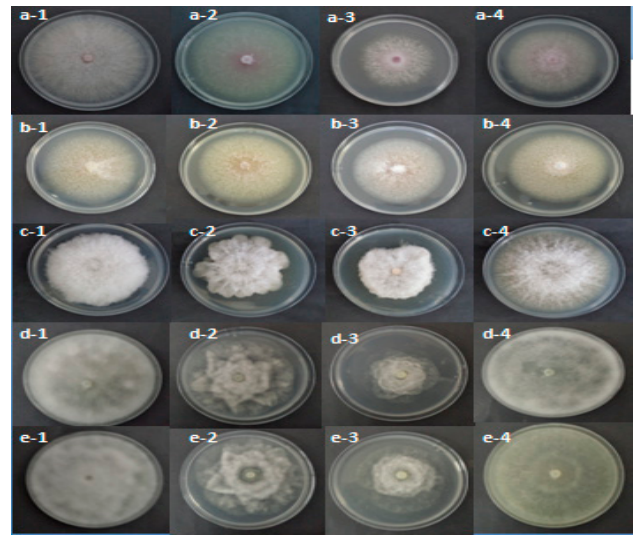
Figure 1. Effect of methanolic (2), dichloromethane (3) ethylacetate extracts (4) on mycelial growth of F. oxysporum ( a ), F. solani ( b ) P. citrophthora ( c ) recorded after six days of incubation and that of